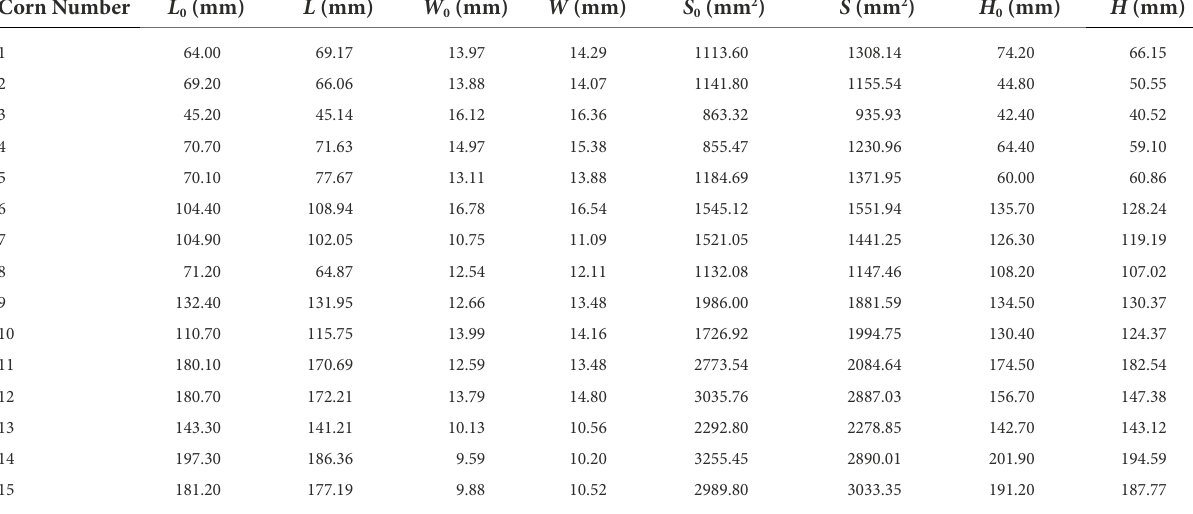
TABLE 2 Measured data of phenotypic parameters of maize. Corn Number